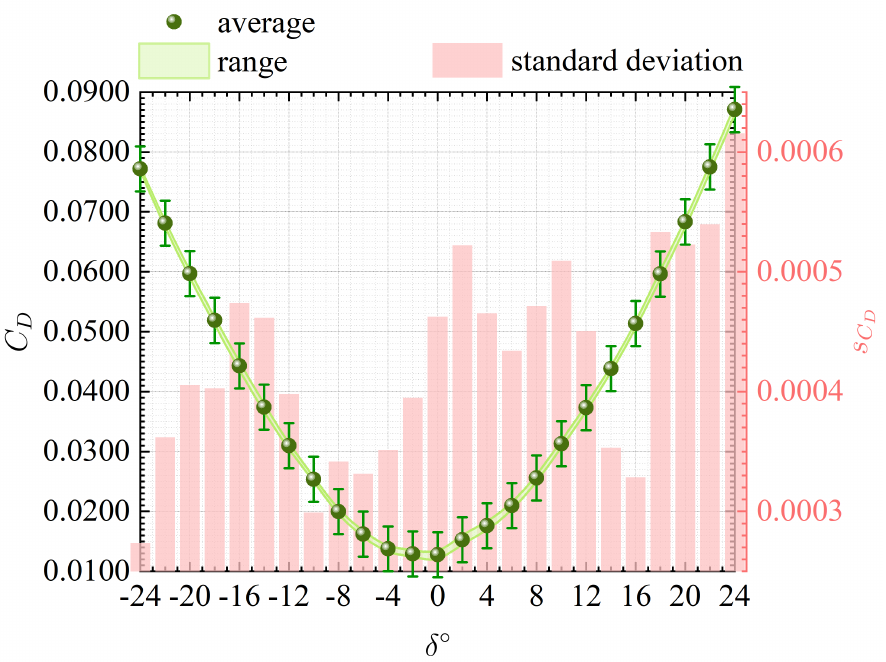
Figure 4. The C D result of the preliminary attempt in the stepwise mode under the conditions of U ∞ = 40 m/s and α = 0 ◦